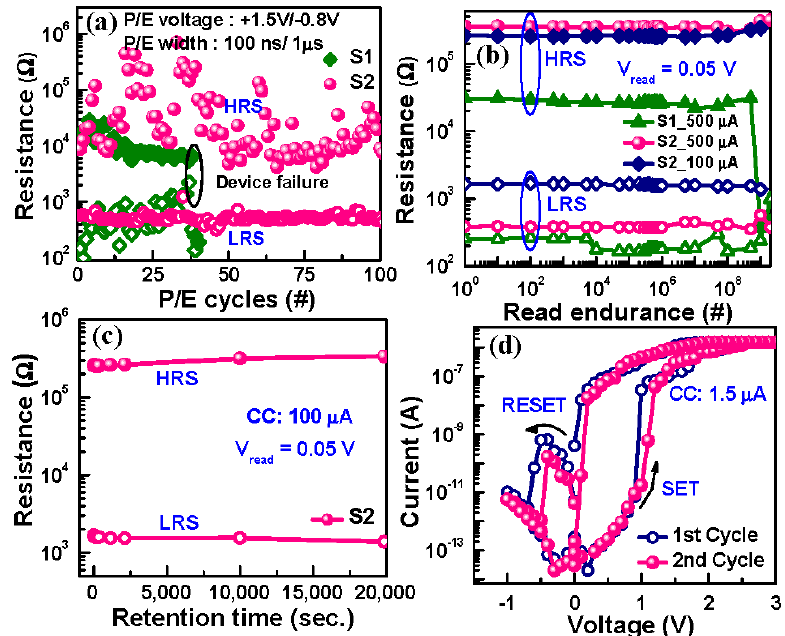
Figure 7. Bipolar resistive switching performance of the S1 and S2 devices. ( a ) Comparison of P/E endurance for the S1 and S2 devices with a high speed of 100 ns. The S1 device has shown failure after a few cycles while the S2 device show longer endurance because of Al 2 O 3 interfacial layer. ( b ) Read endurance of >10 9 cycles of the S2 devices at a low current of 100 µA. ( c ) The S2 device also shows longer retention time about 20,000 s with a good stability at low current compliance of 100 µA. ( d ) The S2 device shows a low current operation of 1.5 µA with a large HRS/LRS ratio of 10 5 at a read voltage of 0.5 V.